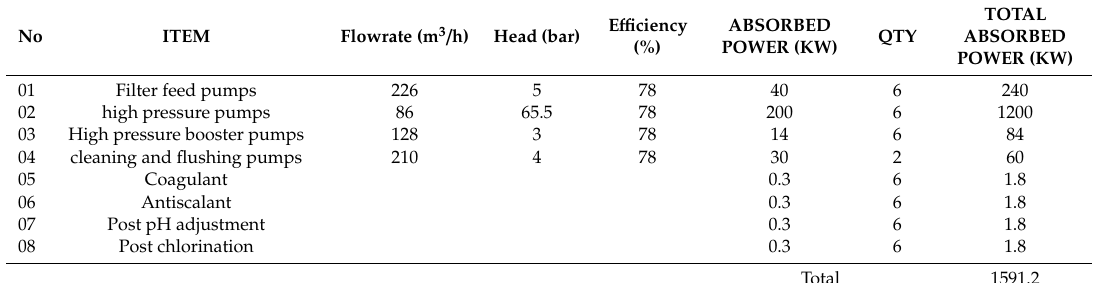
Table 2. Power consumption of each RO module per